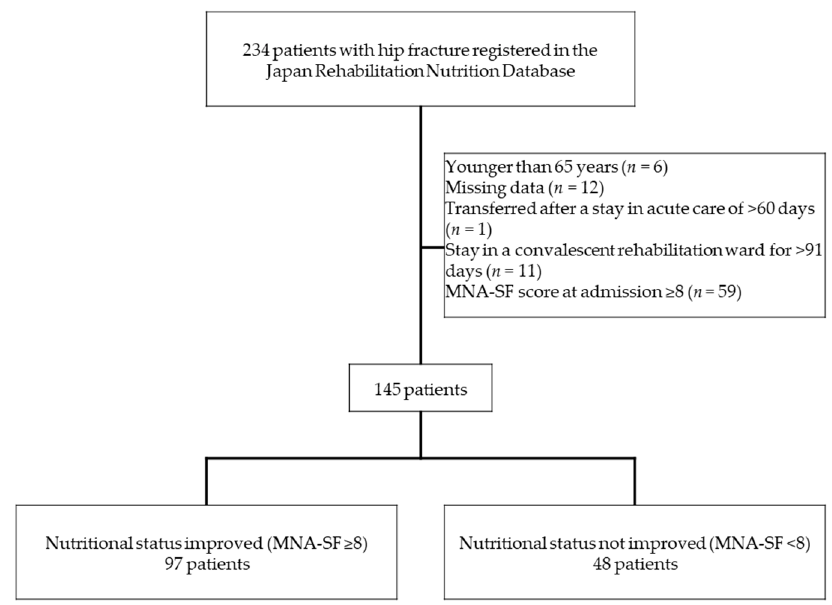
Figure 1. Study design. MNA-SF, Mini Nutritional Assessment-Short